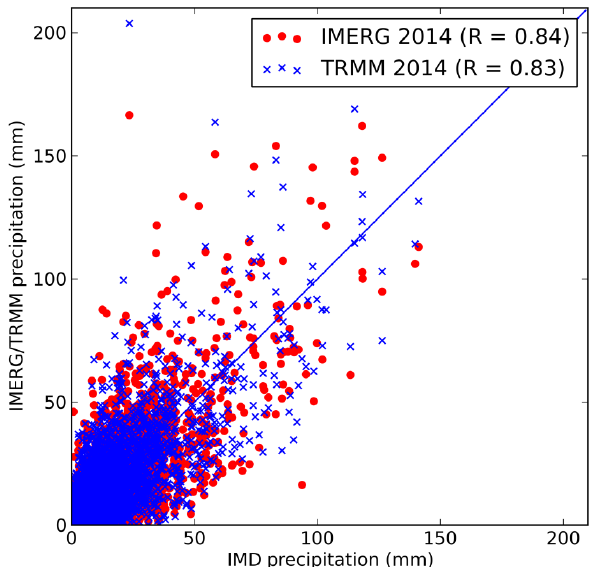
Figure 3. Scatter plot of satellite precipitation products (TRMM and IMERG) vs. observed rainfall (IMD) computed over 86 delin- eated river basins across India (based on daily precipitation data from 12 March to 31 December 2014).